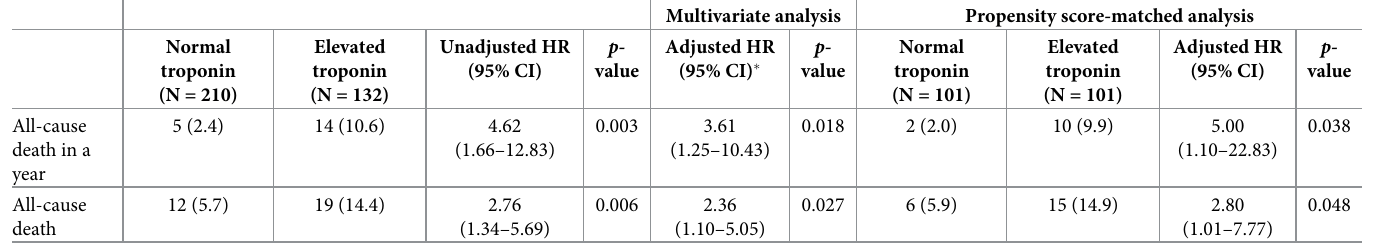
Table 6. All-cause death in the postoperative group (entire and propensity-matched populations).